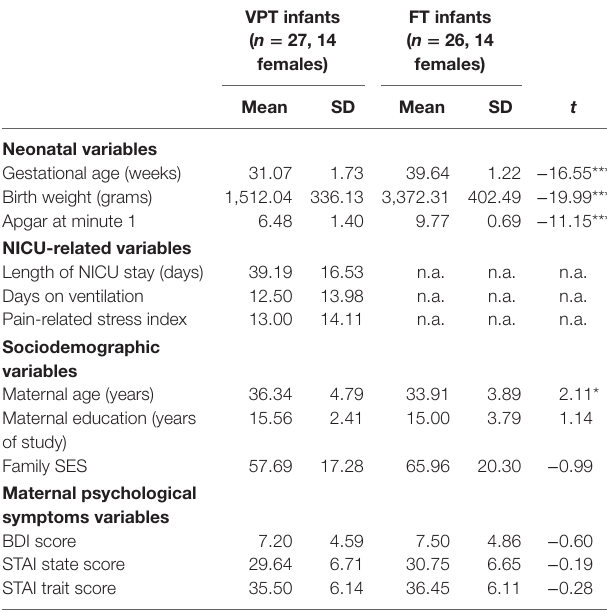
TaBle 1 | Descriptive statistics for the present